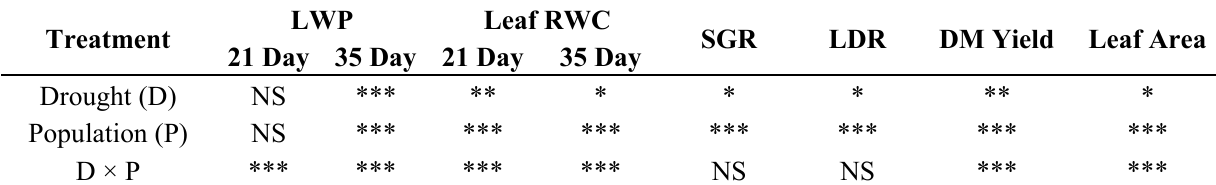
Table 1. Significance levels for effect of drought, population and their interaction on plant growth